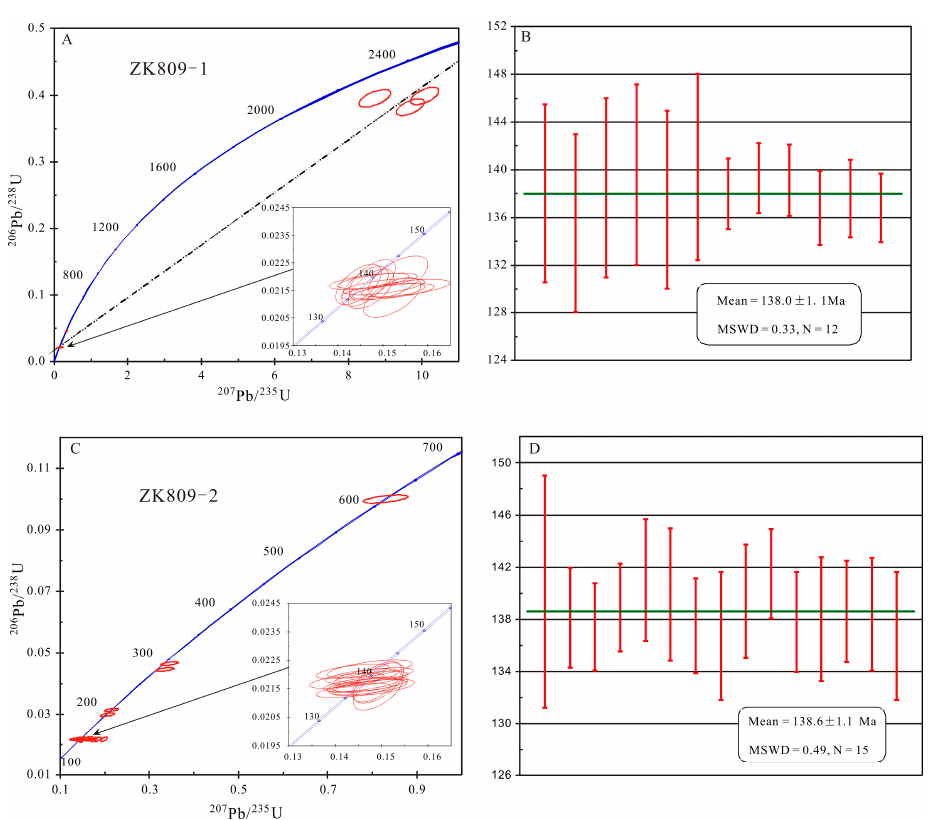
Figure 6. U-Pb Concordia diagram of zircon of quartz porphyry ( A , C ); weighted mean ages of zircon U-Pb dating for quartz porphyry ( B , D ).